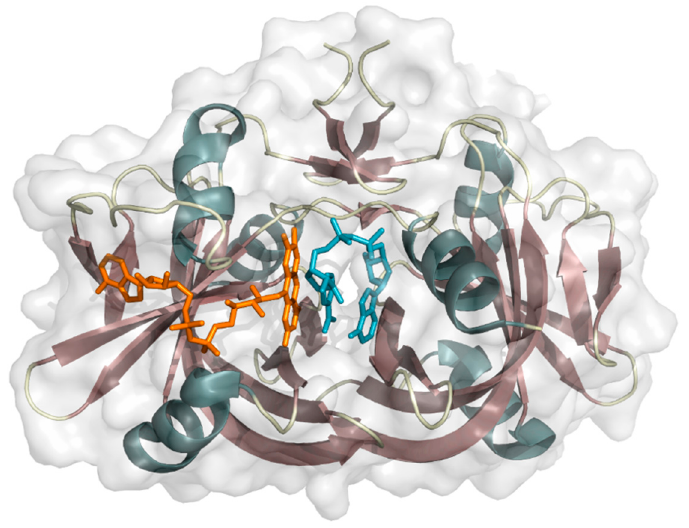
Figure 3. Structure of PheA2 dimer (Protein Data Bank (PDB) ID: 1RZ1). Coloring is according to secondary structure: helices (deep teal), sheets (brown) and loops (pale yellow). Surface is indicated transparently. For clarity, only one FAD (orange) and nicotinamide adenine dinucleotide (NAD) (light blue) is illustrated per dimer. Note that the FAD is reduced and that the NAD coenzyme is bound in a stacked conformation.